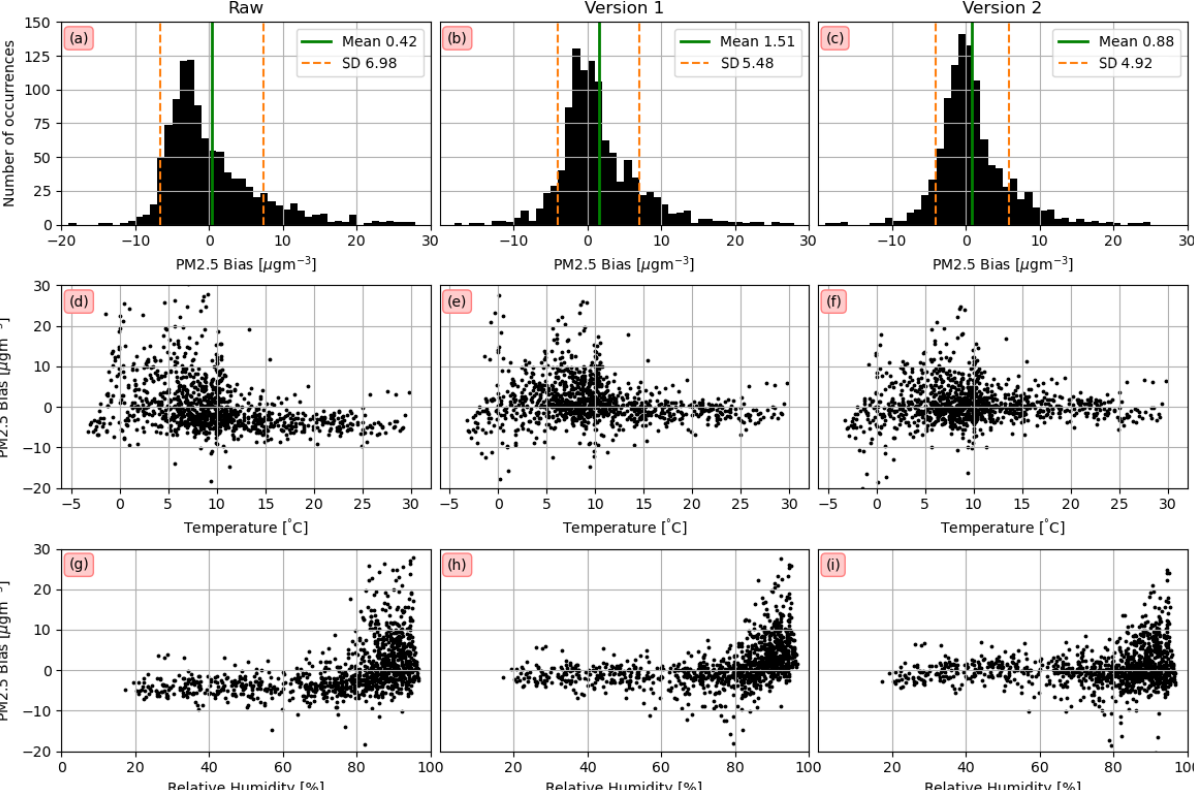
Figure 9. A comparison of hourly means of the raw (a, d, g) , version 1 (b, e, h) , and version 2 (c, f, i) data from ODIN and the TEOM at the St Albans site. Panels (a, b, c) show histograms of bias (ODIN-TEOM) with the mean (green line) and ± 1 standard deviation (orange dashes) indicated. Panels (d, e, f) show scatterplots of the bias against temperature and (g, h, i) show scatterplots of bias against humidity. The instrument ID for the ODIN instrument is